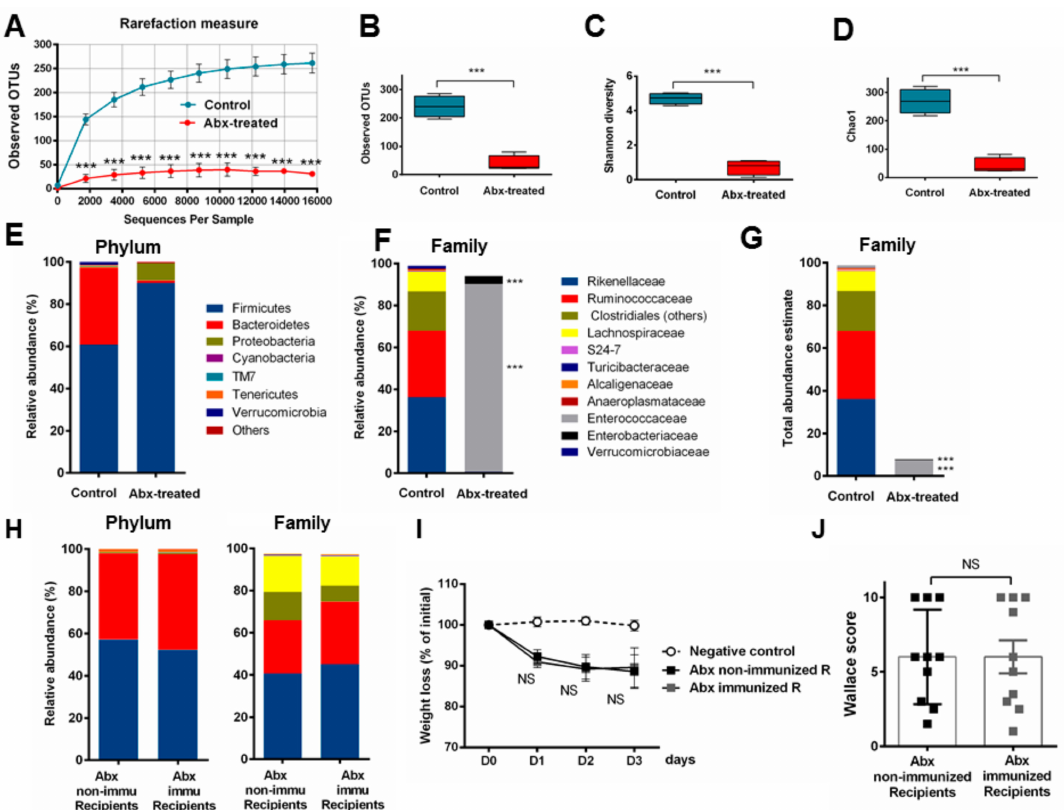
Figure 6. recolonization but did not improve the resistance to colitis following fecal transplantation from P28GST-treated mice. ( A ) Rarefaction curves of observed OTUs as a function of reads showed a huge decrease of sequence numbers in the fecal samples of 5 day antibiotic-treated mice (Abx-treated) compared to the group of control mice. Boxes and whiskers represent ± min / max of observed OTUs. ( B ) Shannon index ( C ) and Chao 1 ( D ) confirms the drop in richness and diversity, n = 4 per group. Mean relative abundances at the phylum ( E ) and family level ( F ) from 16S sequence data demonstrated the drastic reduction of diversity while DNA quantification in fecal pellets allowed us to estimate the lowering of total abundance of bacteria with antibiotics at the family level ( G ). ( H ) Mean relative abundance at the phylum and family level for antibiotic-treated (Abx) recipient mice following (pooled) fecal transplantation from either non-immunized or immunized mice at day 36, n = 5 per group. Results are expressed as % of the total OTU number. ( I ) Percentage of loss of initial weight (prior colitis, at day 36 = D0) expressed as the comparison of individual weights recorded at necropsy (day 39 = D3) as means ± SEM and ( D ) macroscopic clinical (Wallace) scores of colons at day 39 in both non-immunized and immunized recipient group of mice; means ± SEM. n = 10 per group for colitis evaluation parameters ( I , J ); *** p < 0.001; NS, not significantly di ff erent from the positive control